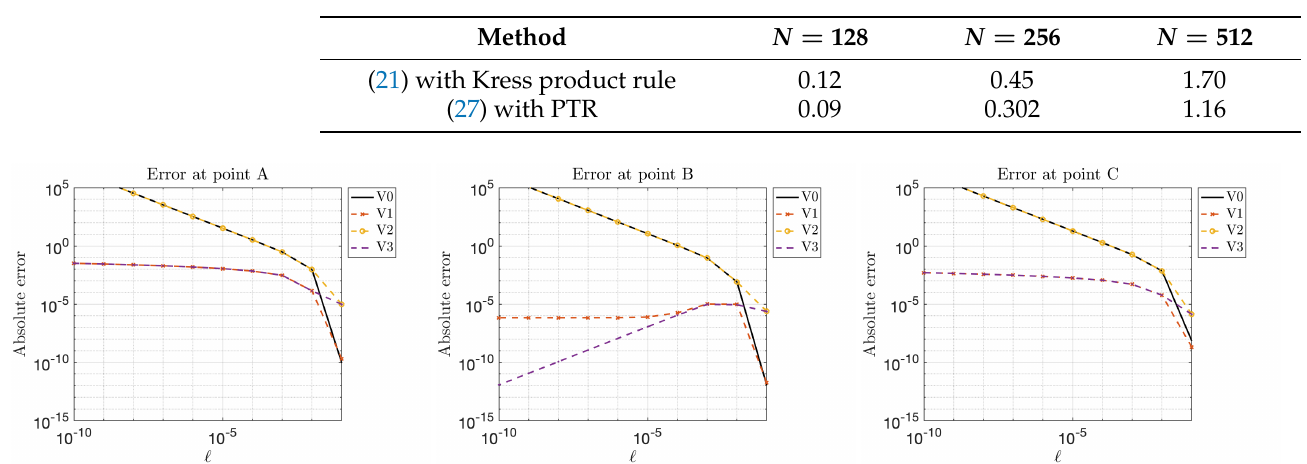
Figure 13. Helmholtz 2D. Log-Log plot of the error along the normal for the solution of (18) out of the star domain defined by the boundary y ( t ) = ( 1.55 + 0.4cos5 t ) ∗ ( cos t ,sin t ) , t ∈ [ 0,2 π ] , for the Dirichlet data, f ( x ∗ ) = i x 0 = ( 0.2,0.8 ) , at the three points A,B, C plotted as black × ’s in Figure 6.